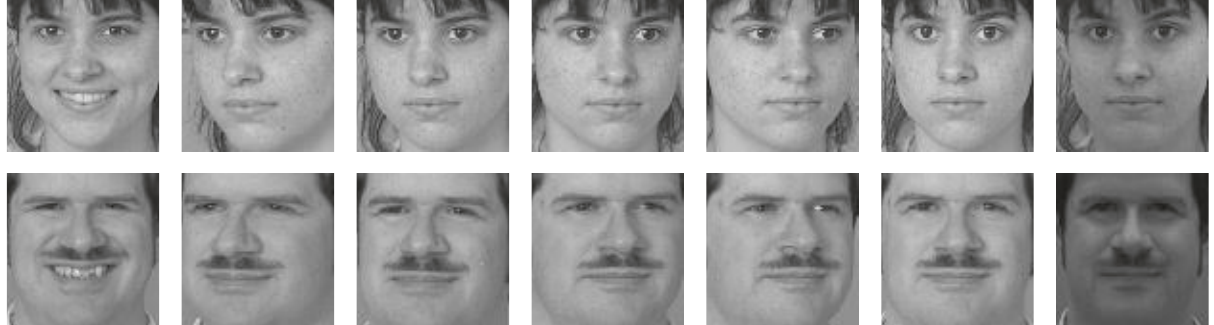
Figure 2: Some face images from the FERET face database.